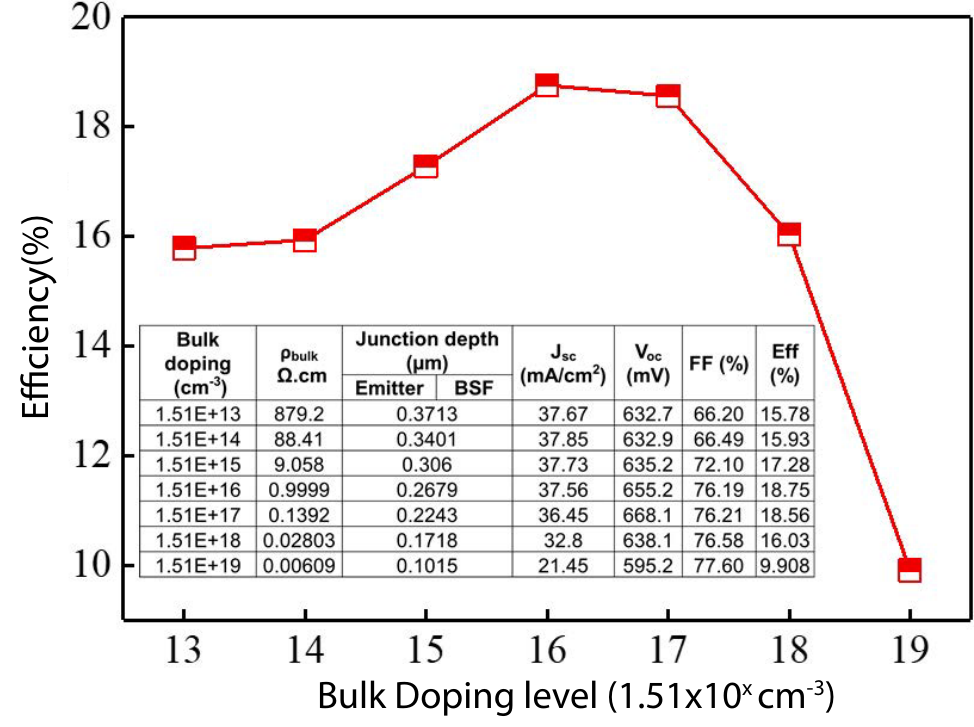
Figure 6. Efficiency variation with respect to bulk doping level. Inset shows the variation in the I–V parameters as function of bulk doping